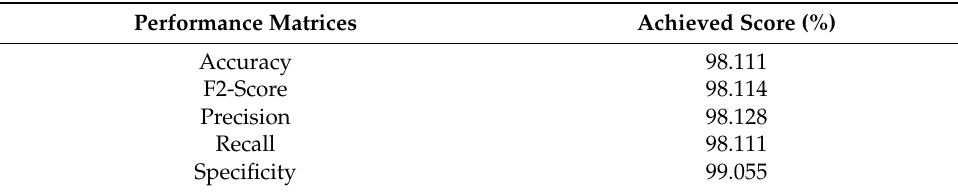
Table 6. Validation confusion matrix of DenseNet201 for three-class classifier.